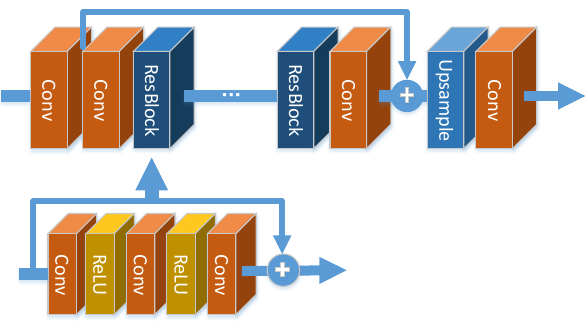
Figure 2. The architecture of the proposed multibranch network.